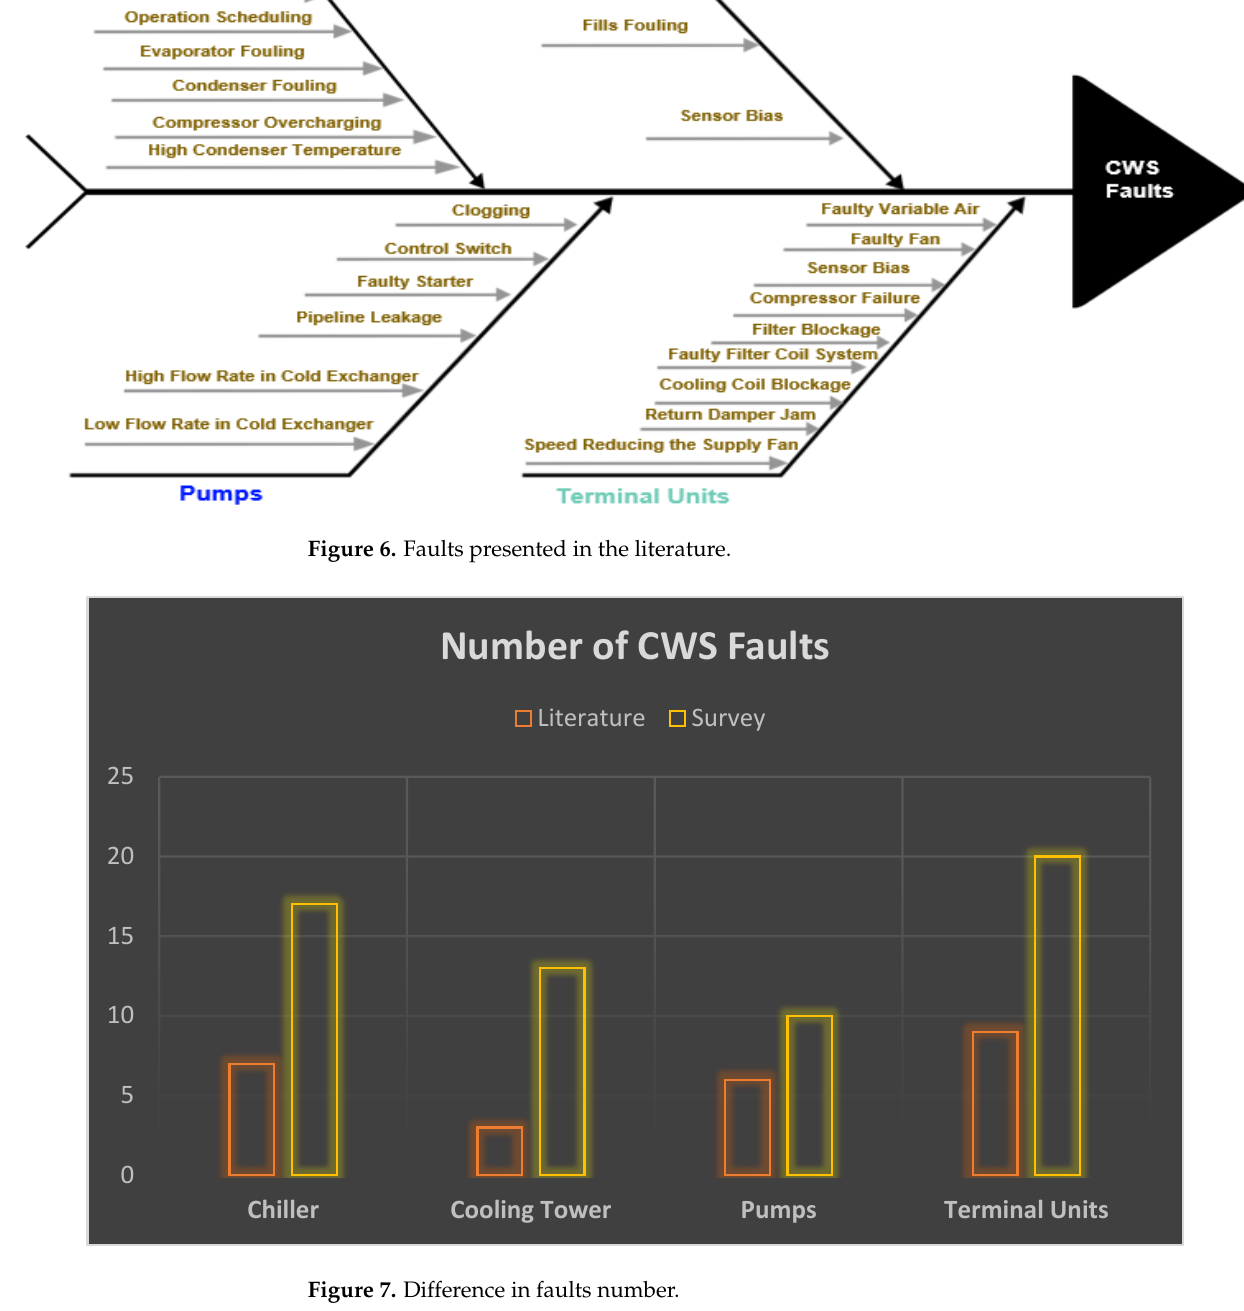
Difference in faults